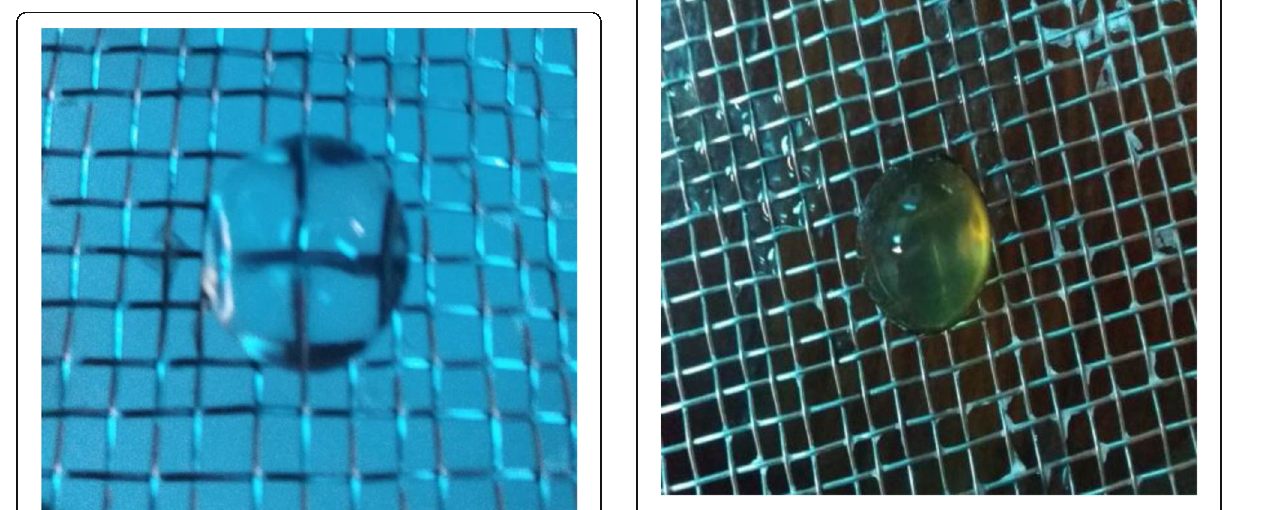
Fig. 12 Group III (cataract treated with 150 μ g/ml of ethanolic